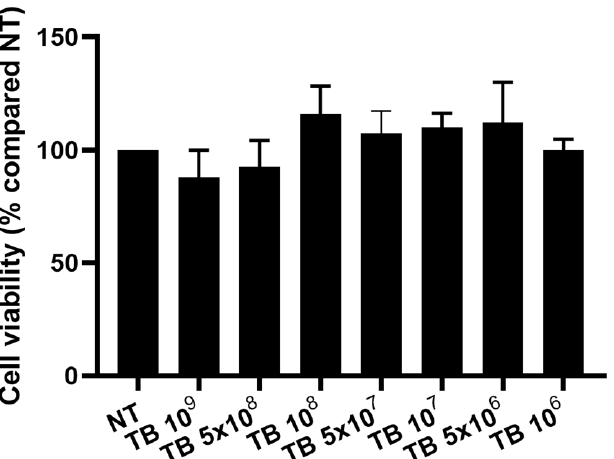
Figure 1. Effect of TB on the viability of THP-1-derived macrophages. THP-1-derived macrophages were incubated with different concentrations of TB and the effect on the viability was assessed by MTS assay. Data are expressed as mean ± SD (N = 3).